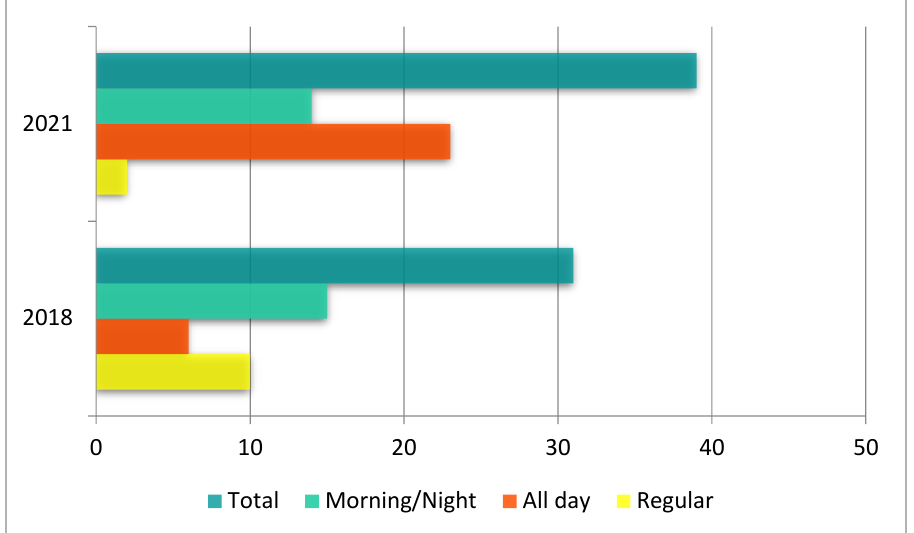
Figure 12. Comparison of Traditional Fairs data in 2021 and 2018 (Source: Own drawing; Data source: On-site investigation).